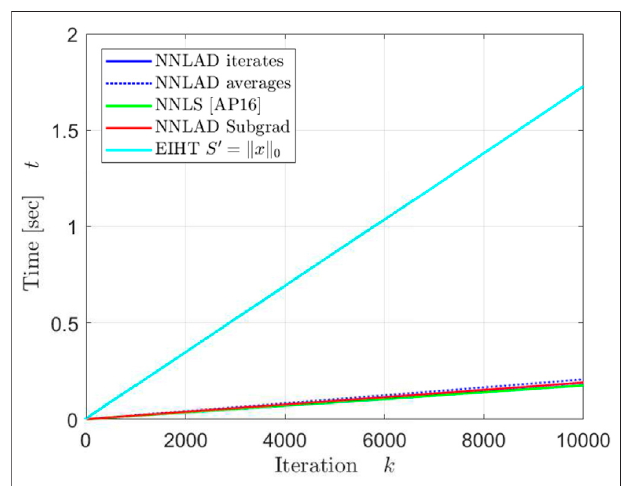
FIGURE 7 | Time required to perform iterations of certain iterated